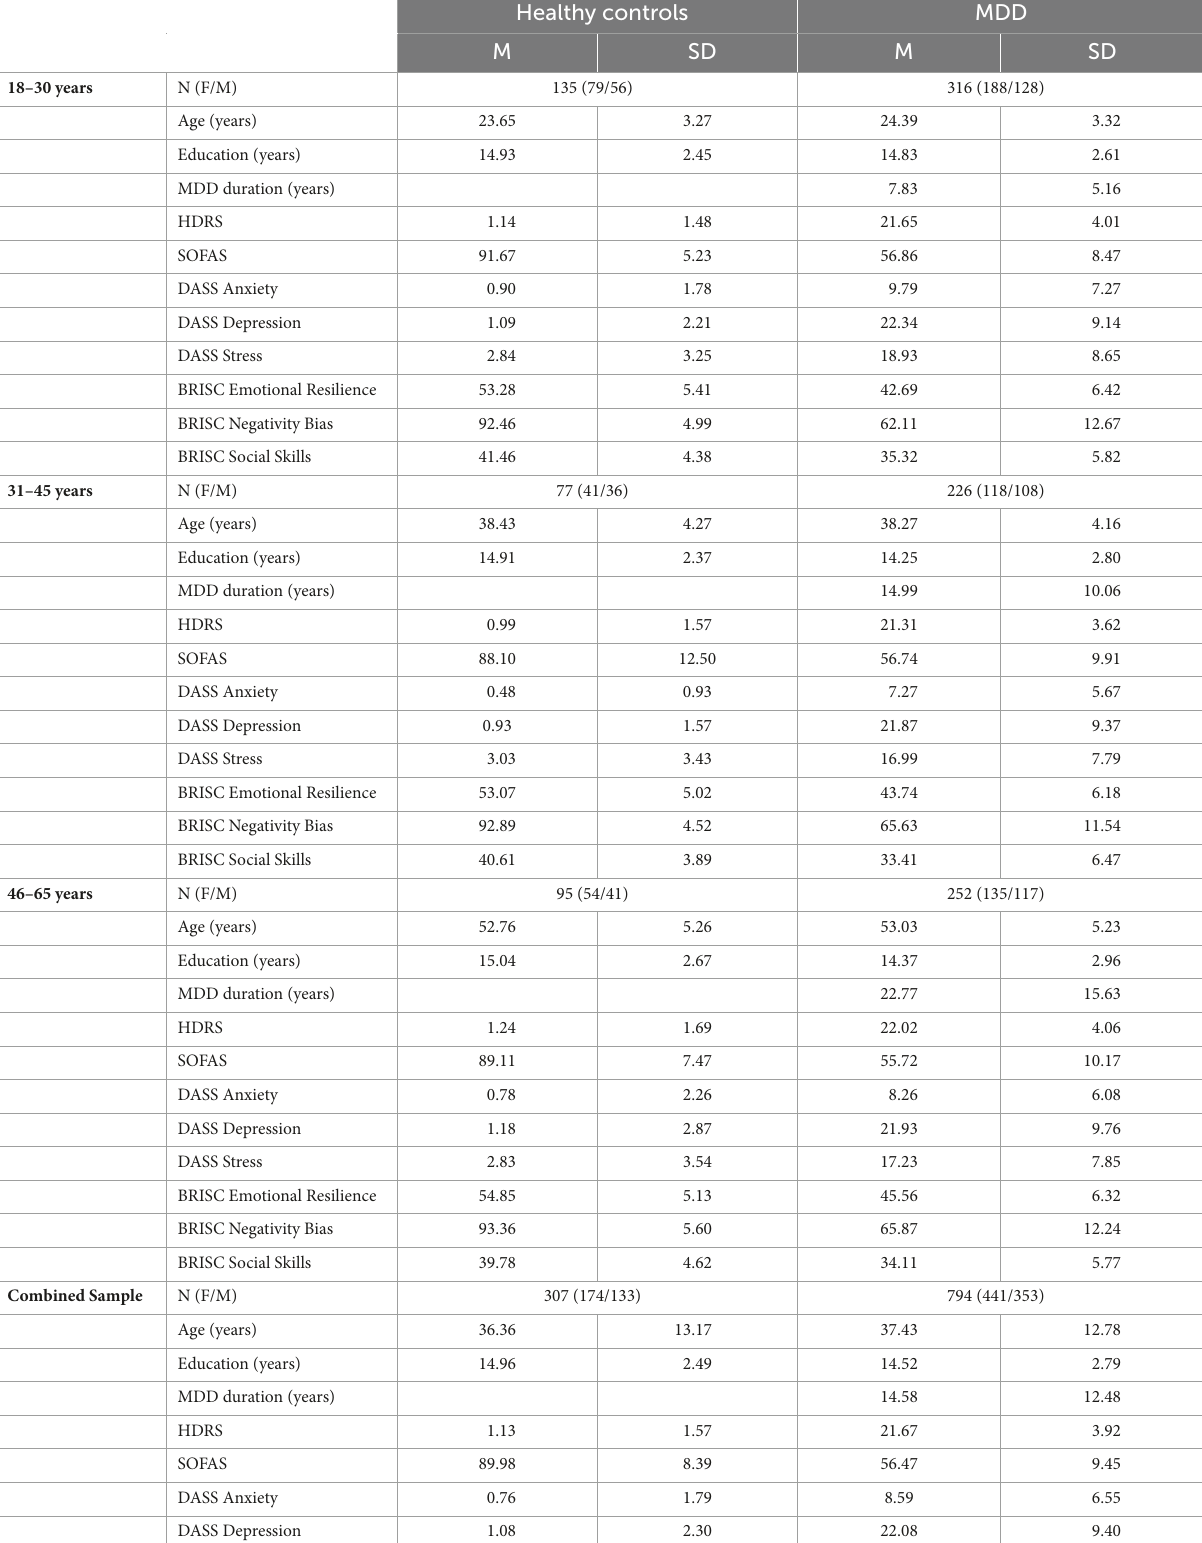
TABLE 1 Demographic and clinical characteristics of the iSPOT-D study participants used in the current analysis. Healthy controls MDD M SD